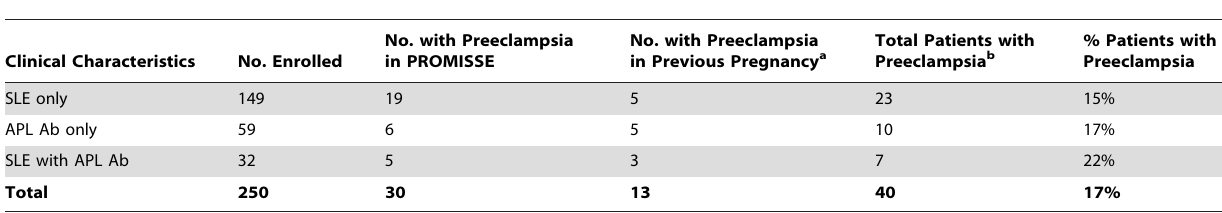
Table 1. Preeclampsia in autoimmune PROMISSE